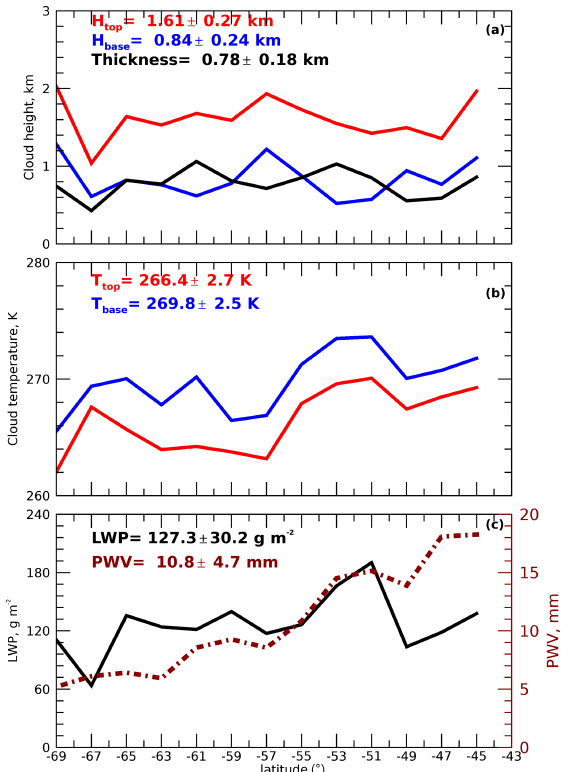
Figure 8. Meridional variations in single-layered, low-level cloud properties. (a) Cloud base ( H base ) and cloud-top ( H top ) heights and cloud thickness ( (cid:49)H ). (b) Cloud base ( T base ) and cloud-top ( T top ) temperatures. (c) Cloud liquid water path (LWP) and precipitable water vapor (PWV) over the entire domain during MARCUS.